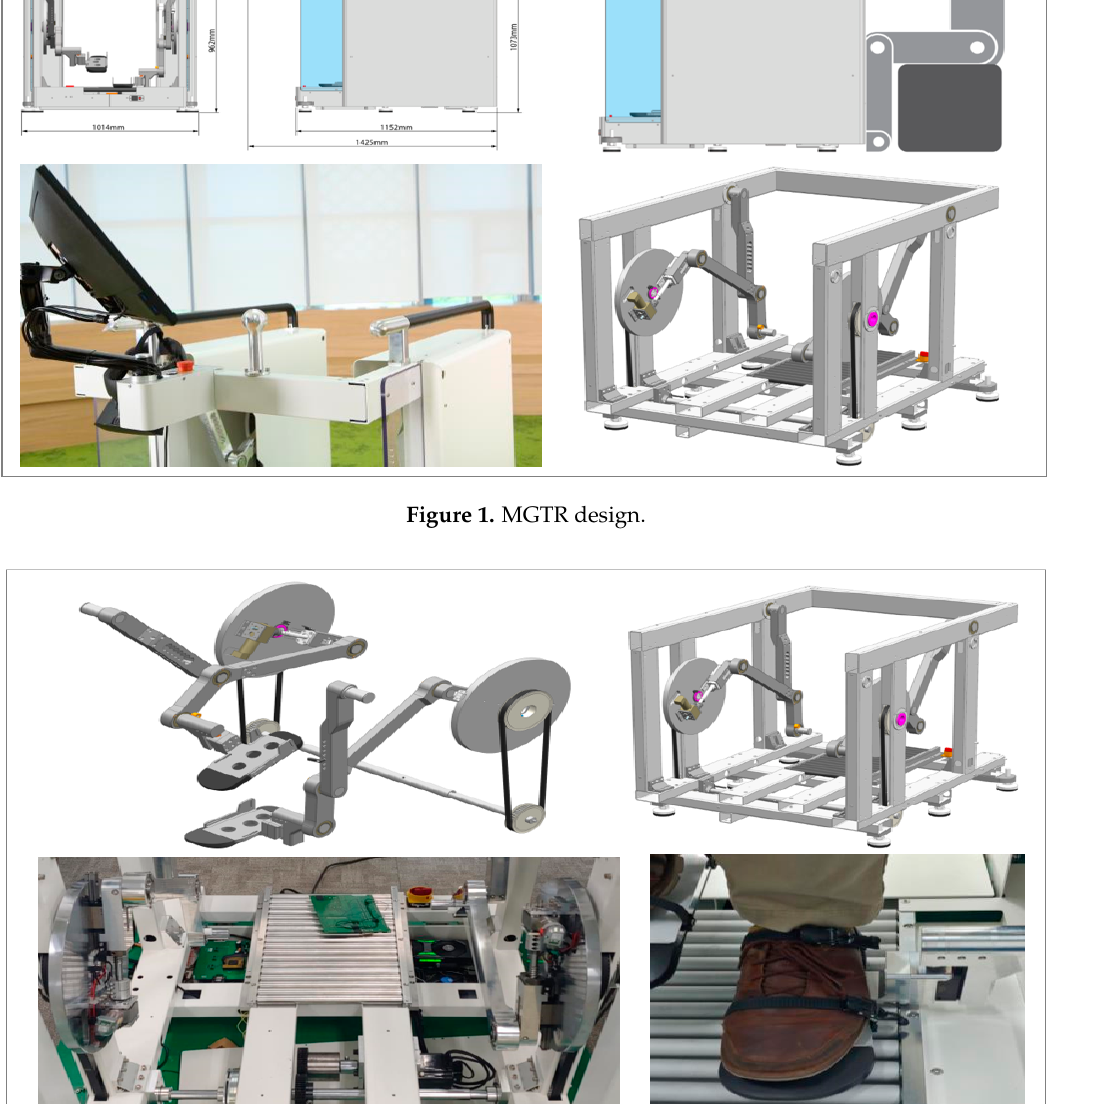
Figure 1. MGTR design.